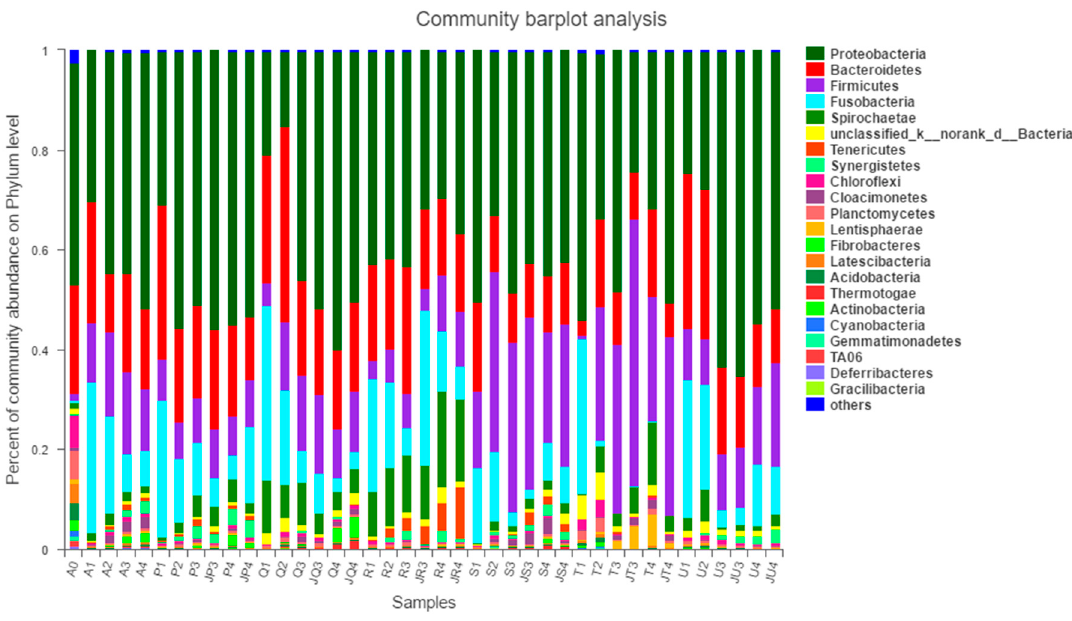
Figure 6. Composition and relative abundance of di ff erent phyla in all samples. A—control group; P—zinc bacitracin-treated group; Q—ciprofloxacin-treated group; R—ampicillin sodium-treated group; S—chloramphenicol-treated group; T—tylosin-treated group; U—tetracycline-treated group.